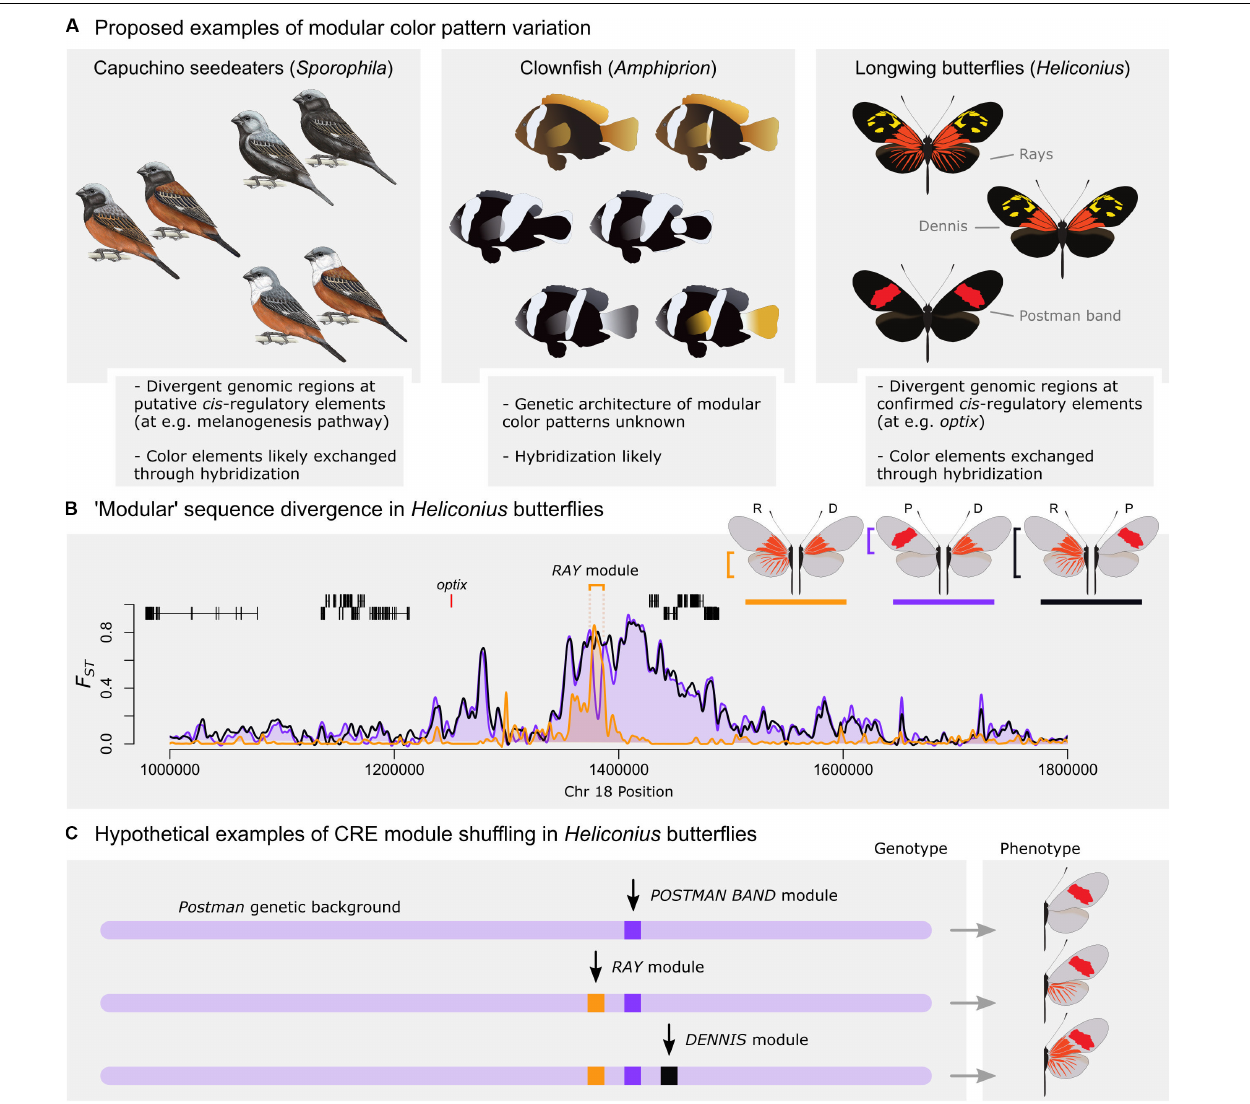
FIGURE 1 | Examples of putative modular color pattern diversity. (A) Examples of potential exchange of modular phenotypes via recombination include plumage patterns in capuchino seedeaters (left, reprinted from Campagna et al., 2017), white stripes in clownfish (middle, modified from Salis et al., 2018), and red wing color patterns in longwing butterflies (right). (B) Genomic differentiation ( F st ) between red wing pattern morphs in Heliconius erato at the optix locus (data from hybrid zones in French Guiana; Van Belleghem et al., 2017). Orange: Differentiation between radiate (R) and dennis (D) morphs; Purple: Differentiation between postman (P) and dennis (D) morphs; and Black: Differentiation between radiate (R) and postman (P) morphs. A single locus, called Ray module, shows a putative cis- regulatory module controlling differentiation between the radiate and dennis morphs. (C) Model of CRE module shuffling assuming these divergent loci function as developmental modules. In this case, different combinations of CRE modules would generate modular alternative phenotypes. Note however that the proposed phenotypes with both a red forewing band and dennis/rays on the right have not been found in a homozygous state in nature and suggest that recombination has not occurred (F1 hybrids can have these phenotypes due to dominance effects of optix